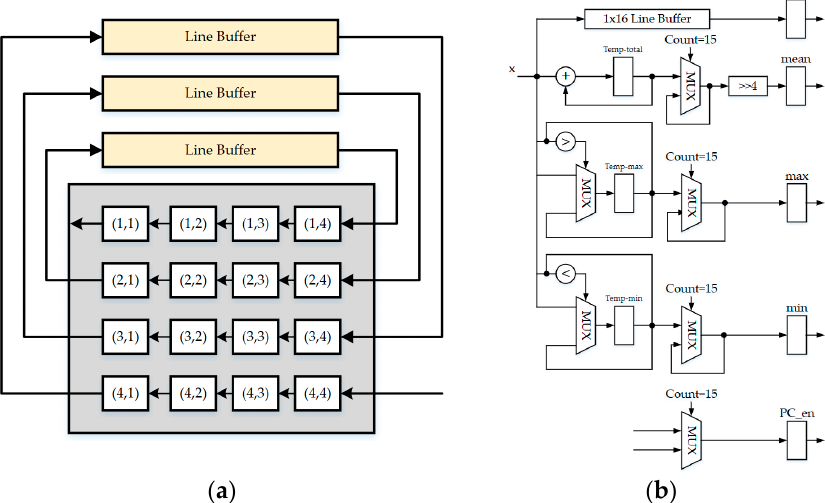
Figure 7. The modular structure of this study. ( a ) Register bank module. ( b ) Parameter calculator module.